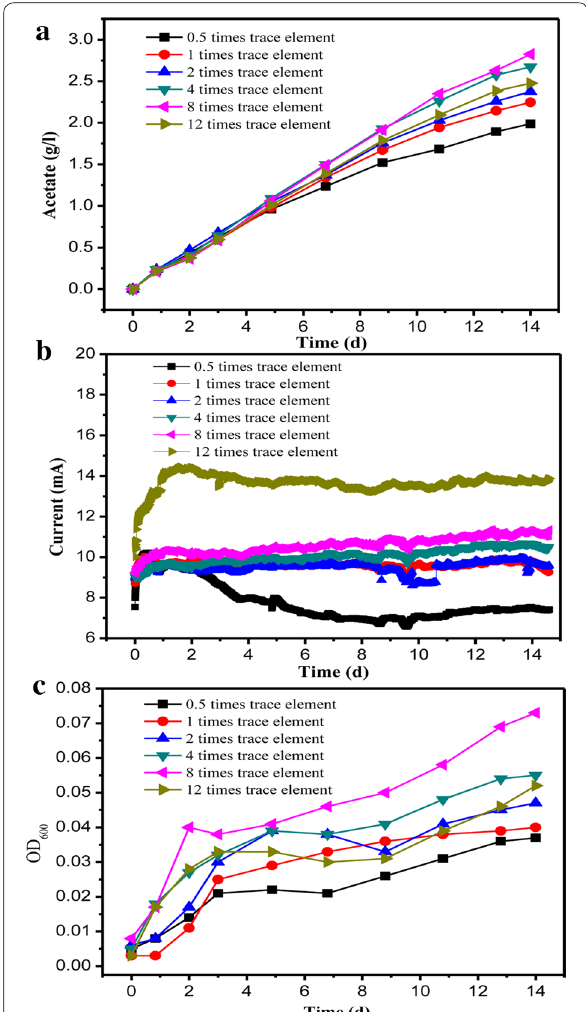
Fig. 4 Effect of trace elements on the MES performance in terms of a acetate production, b current, and c OD